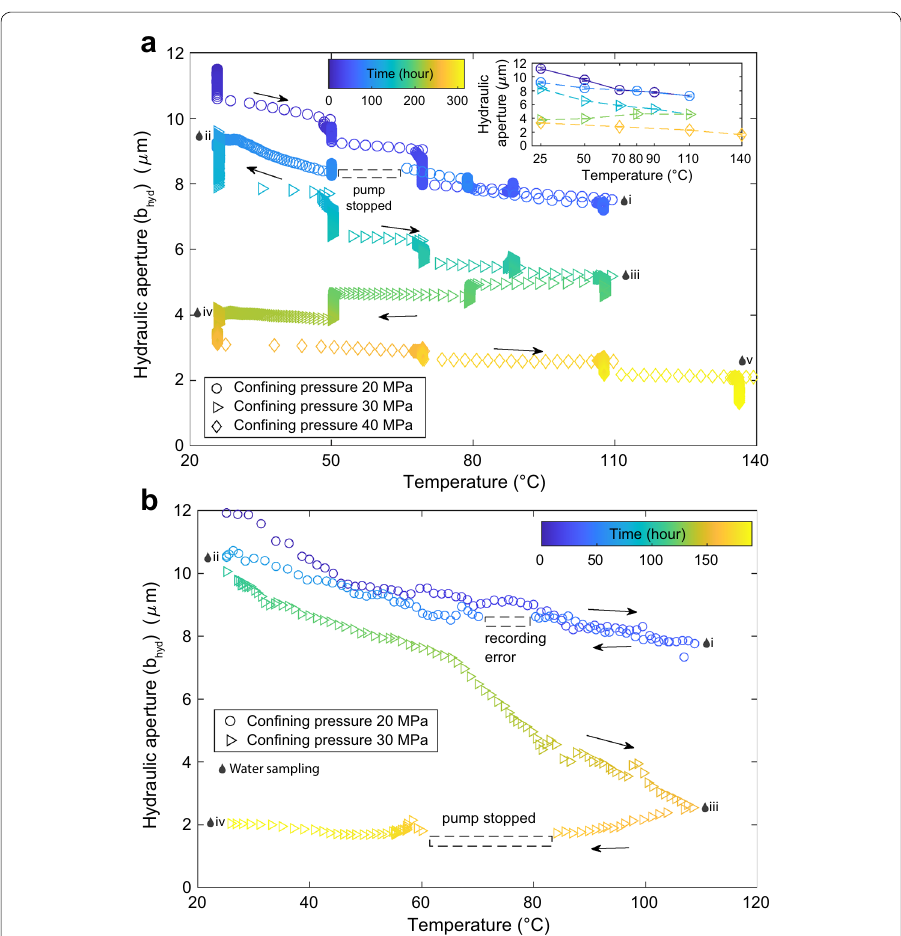
Fig. 7 Evolution of hydraulic apertures. a Step‑wise heating experiments ( # N14‑S1, # N14‑S2, and # N14‑S3) using Specimen N14 under 3 different confining stresses (20, 30, and 40 MPa). Inset: discrete hydraulic apertures at steady‑state conditions. b Constant‑rate heating experiments ( # N19‑C1, # N19‑C2) using Specimen N19 under 2 different confining stresses (20 and 30 MPa). All experiments were performed with a pore‑fluid pressure of 15